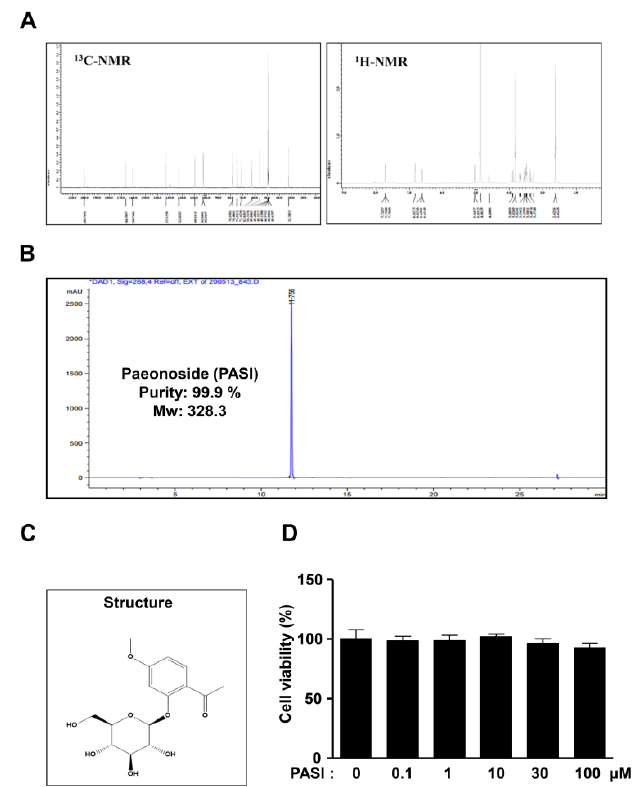
Figure 1. Effects of PASI on cytotoxicity against pre-osteoblasts. ( A – C ) PASI (99.9 % purity) obtained from the dried roots of Paeonia suffruticosa was analyzed by 1 H and 13 C NMR spectra ( A ), HPLC chromatogram ( B ), and chemical structure ( C ). ( D ) Cells were treated with 0.1–100 µ M PASI for 24 h. Cell viability (%) was measured by using an MTT assay. Data are expressed as the mean ± S.E.M. of